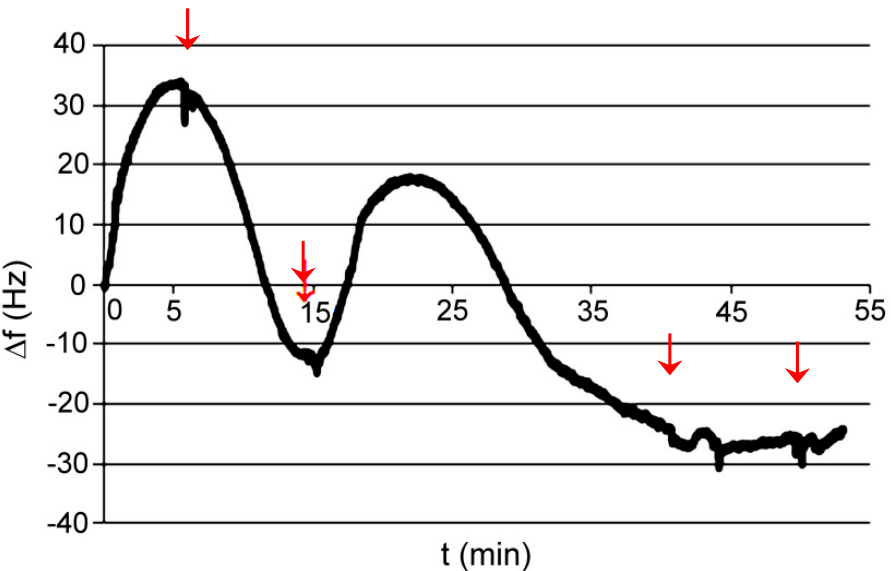
Figure 14. Changes of frequency in time for XVI polymer; absorbed compound—acetylsalicylic acid in acetonitrile.